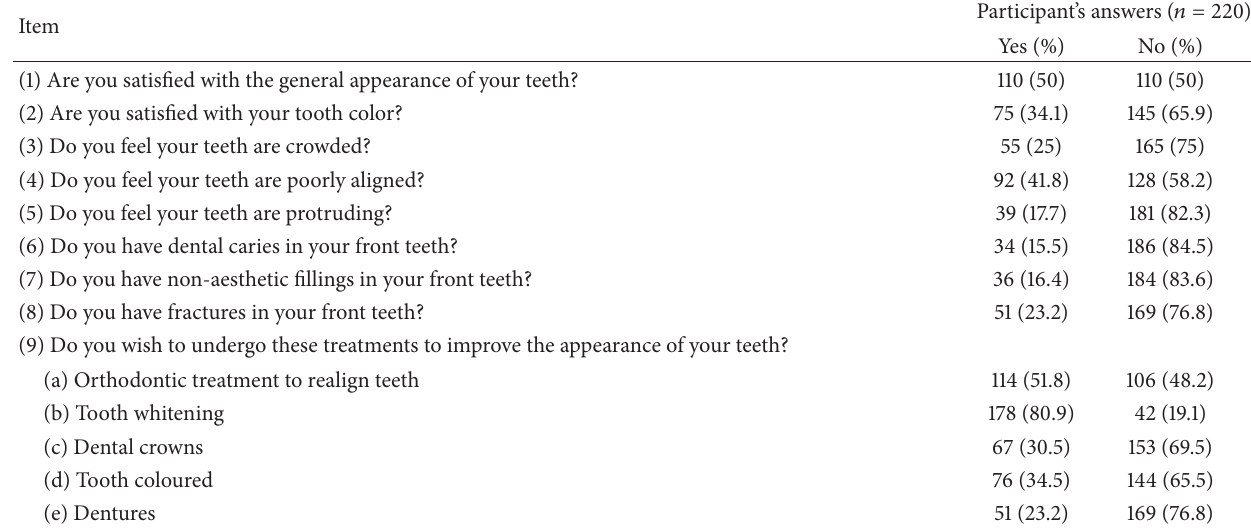
Table 3: Distribution of the study sample by their answers to the questionnaire